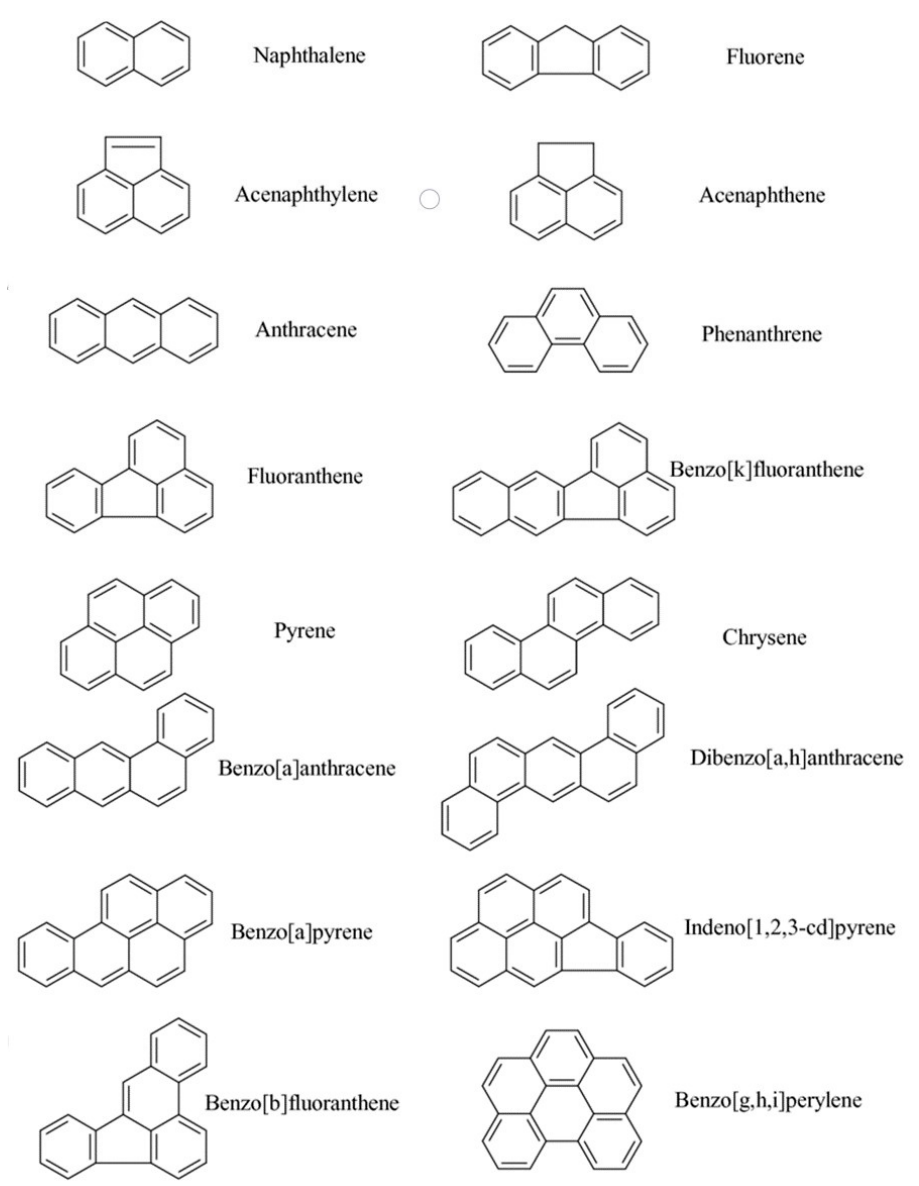
Figure 1. Structure formulas of the 16 priority PAHs (polycyclic aromatic hydrocarbons) according to US EPA.